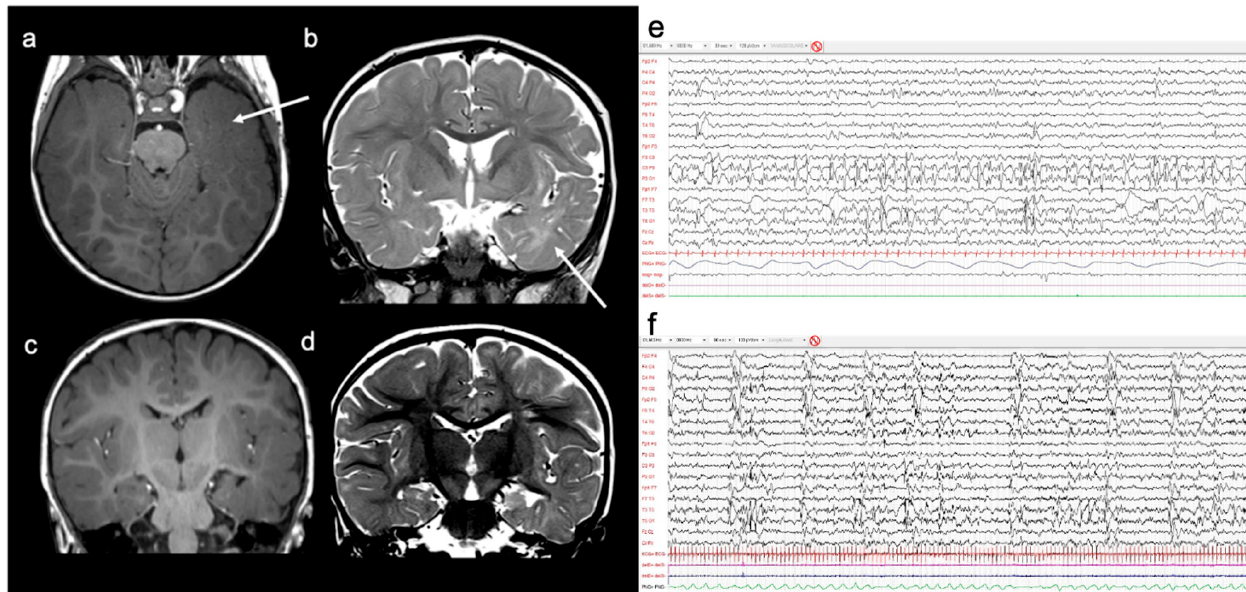
Figure 2. Magnetic resonance imaging T1-weighted images demonstrating left temporal pole volumetric reduction associated with blurring of the cortico-subcortical region ( a , arrow) and hyperintensity of the white matter on T2-weighted sequences ( b , arrow). There is incomplete hippocampal inversion on the left ( c ) associated with increased T2 signal ( d ). ( e ) EEG during Wakefulness shows continuous left temporo-occipital slow and epileptiform abnormalities, with sporadic contralateral expression. ( f ) Periodic complexes of slow waves after awakening associated with subtle eyes elevation, recorded in 60 s.